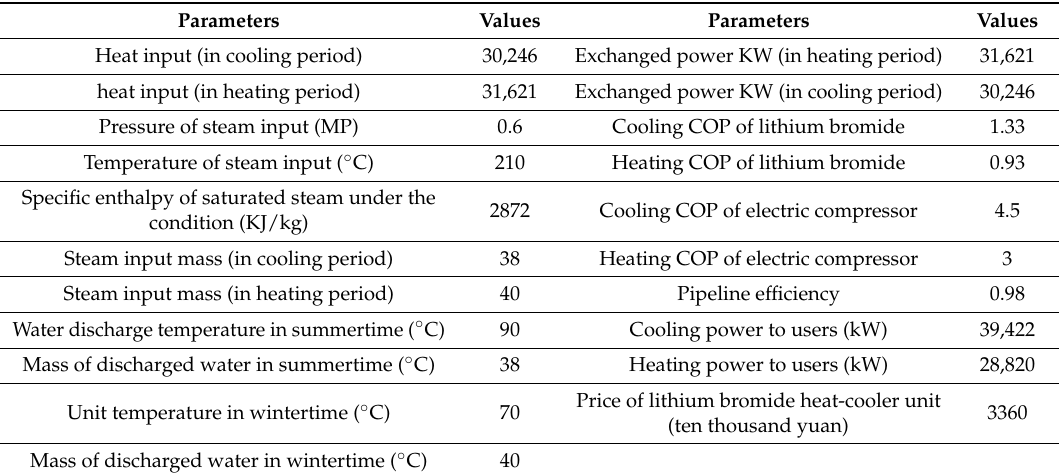
Table 5. Operation parameters of lithium-bromide